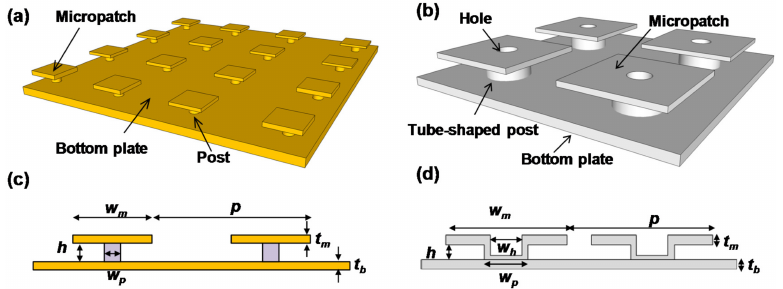
Figure 10. Schematic and cross-sectional images of MR-PMAs with ( a , c ) cylindrical and ( b , d ) tubular posts.